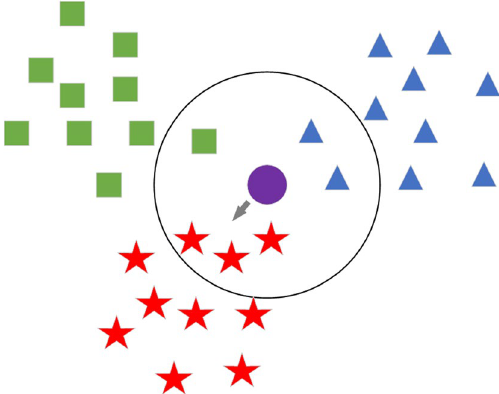
Fig. 6 KNN principle